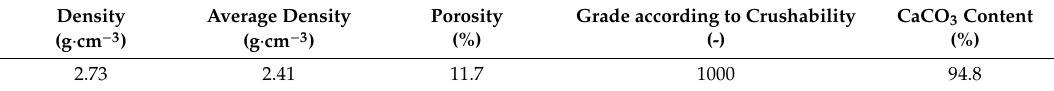
Table 2. Characteristics of Balaklava deposit limestone.